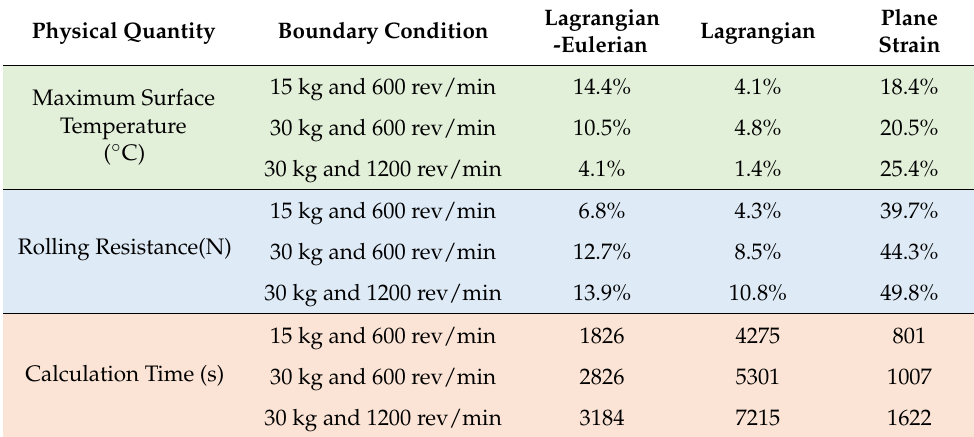
Table 6. The relative error values of the simulation data and test data of the maximum steady-state surface temperature and rolling resistance of the three finite element models of the solid tire under different rolling conditions, and the calculation time corresponding to all simulation analysis